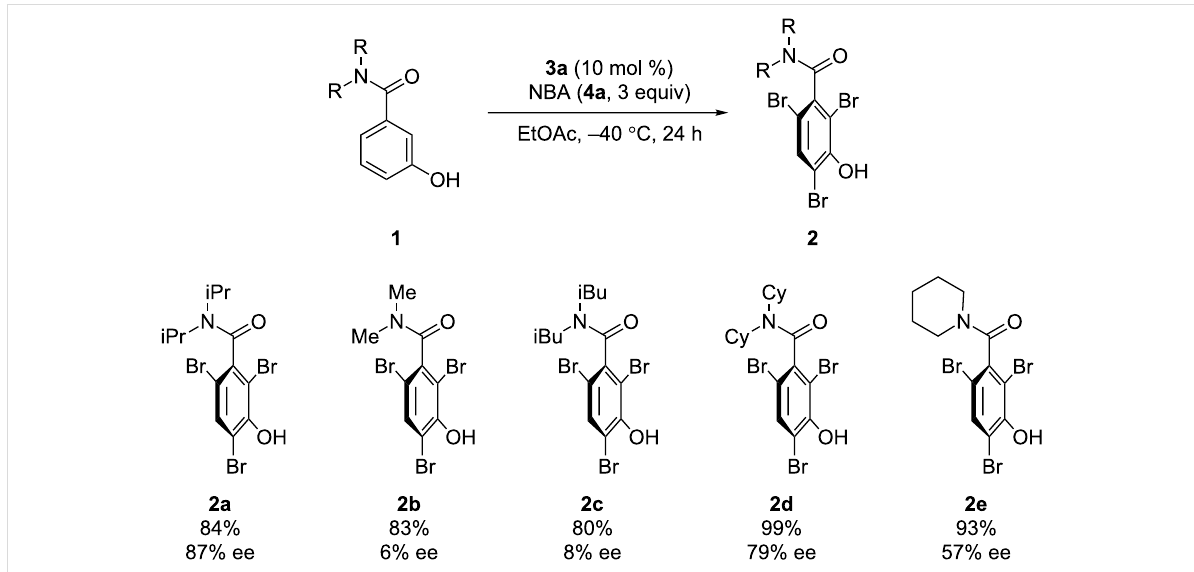
Scheme 1: Optimization of the substituents of the amide group. Reactions were run using 1 (0.1 mmol), 3a (0.01 mmol), and 4a (0.3 mmol) in EtOAc (10 mL). Yields represent material isolated after silica gel column chromatography.